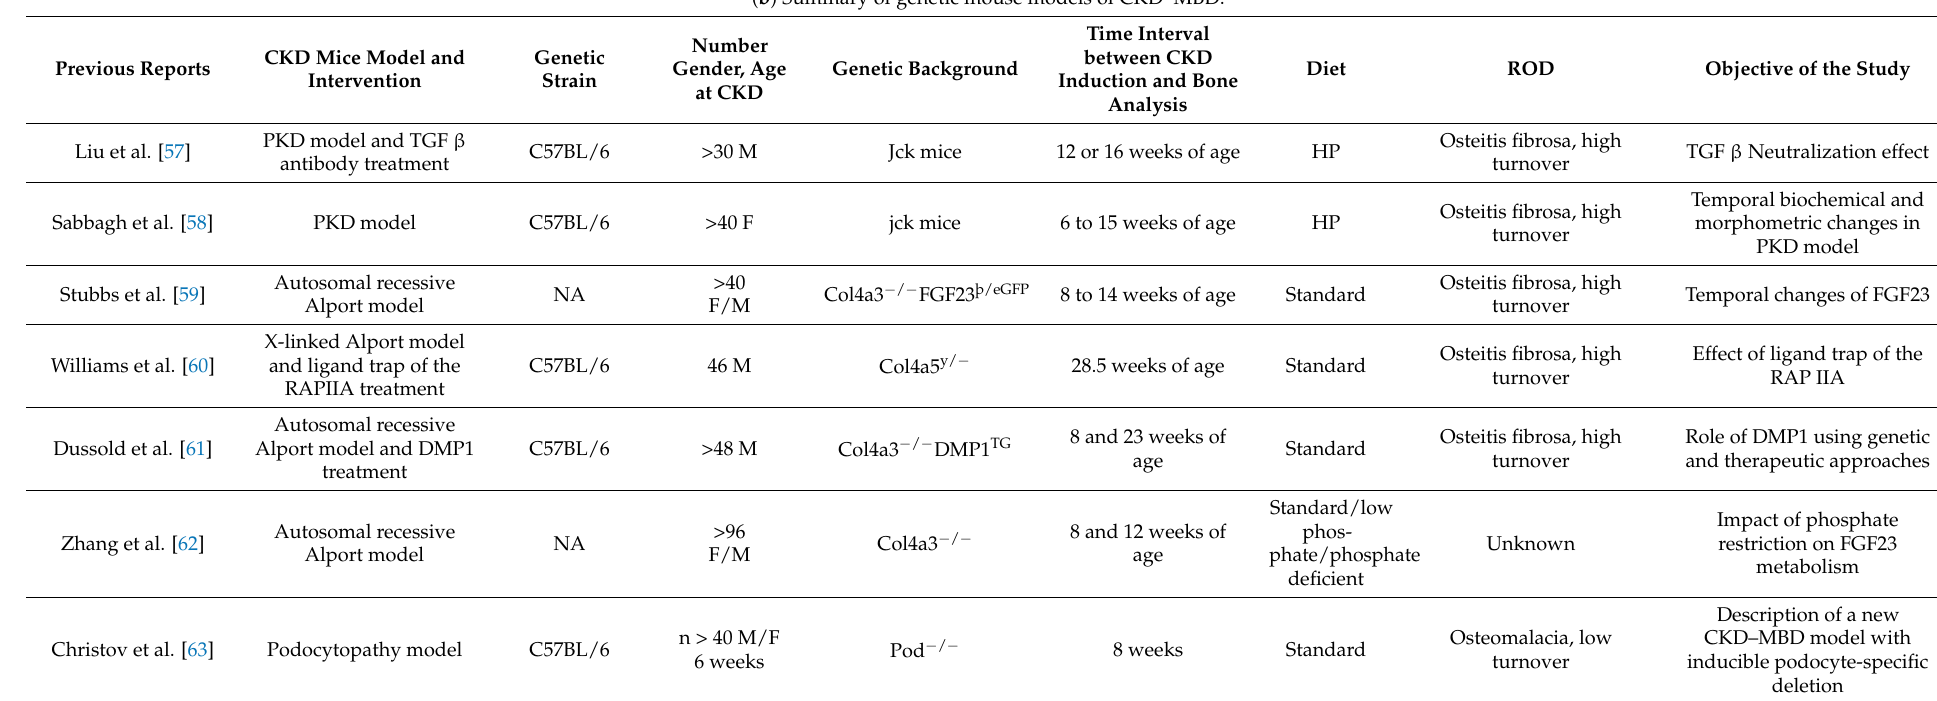
( b ) Summary of genetic mouse models of